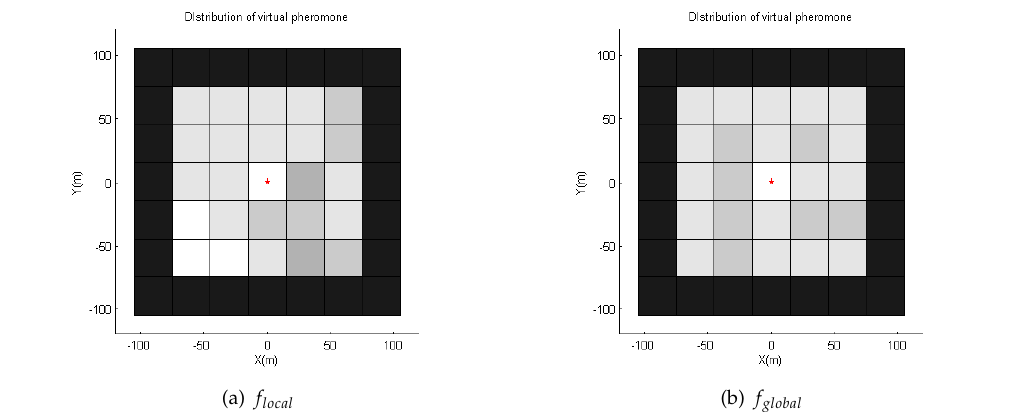
Figure 11. Pheromone distribution with f local and f global . In our test, the AOI is scattered into 5 × 5 grids with Algorithm 1. The color of each square indicates the density of pheromone: the darker a square, the greater the pheromone density is. The edge of the AOI is black and the corresponding pheromone density is ∞ , preventing the robots from going out of the AOI. The red star indicates a communication node. With f global , pheromone has been deployed into the whole area, but it is not the case when using f local . In addition, the density with global is more